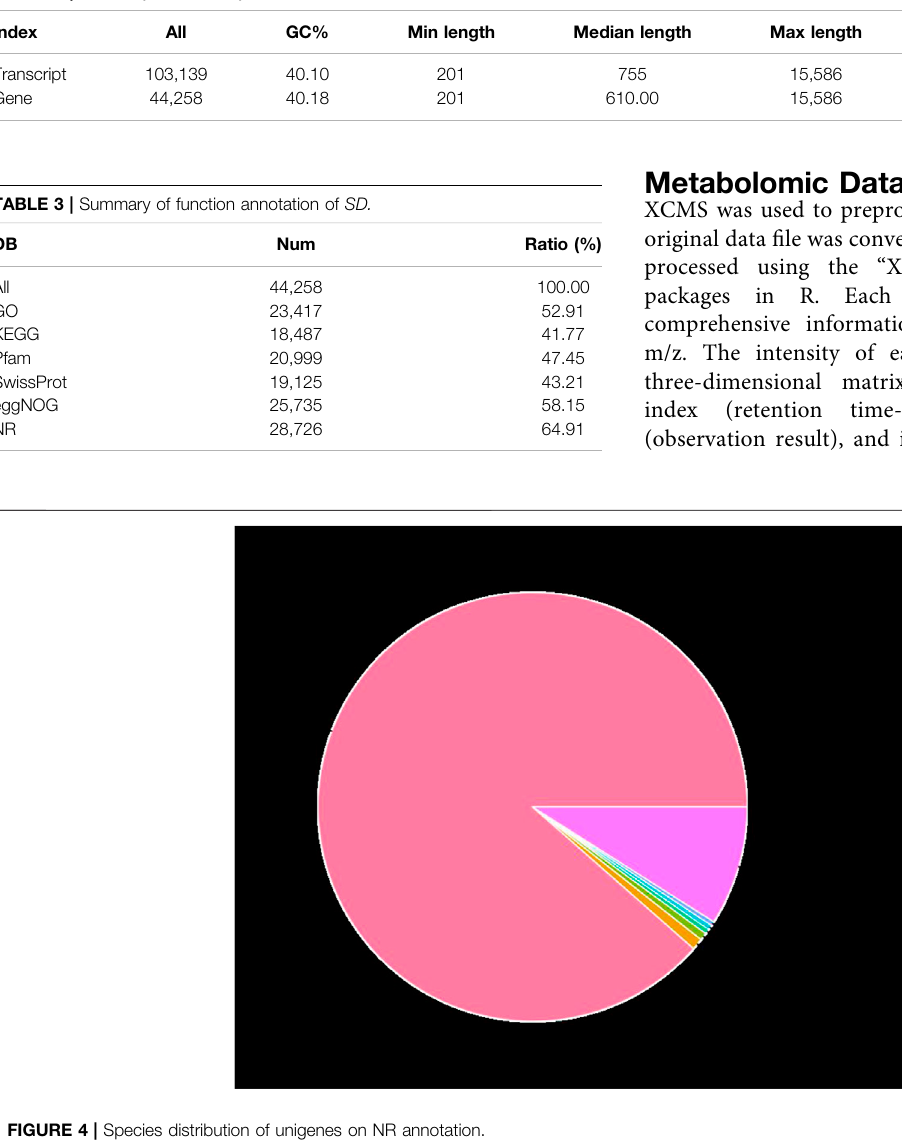
TABLE 2 | Summary of assembly results of SD.